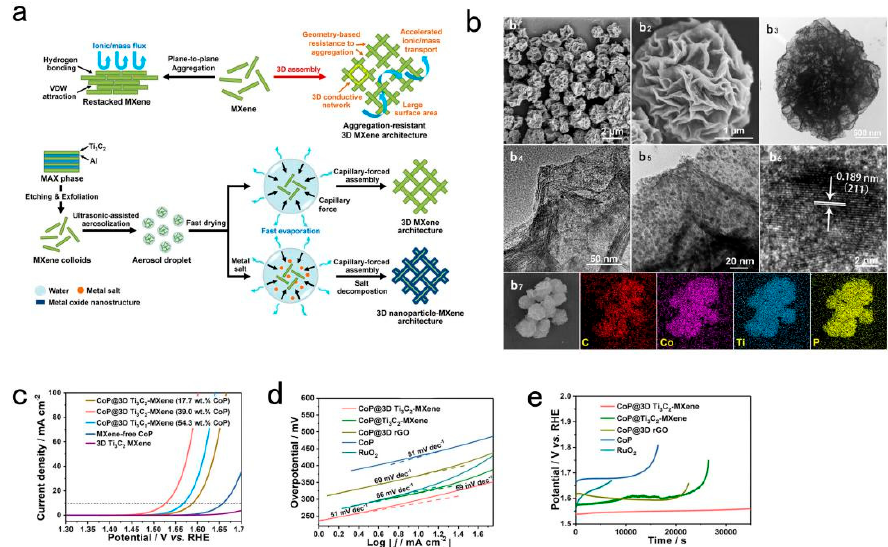
Figure 13. ( a ) Fabrication, hybridization, and advantages of the 3D MXene architecture. ( b )